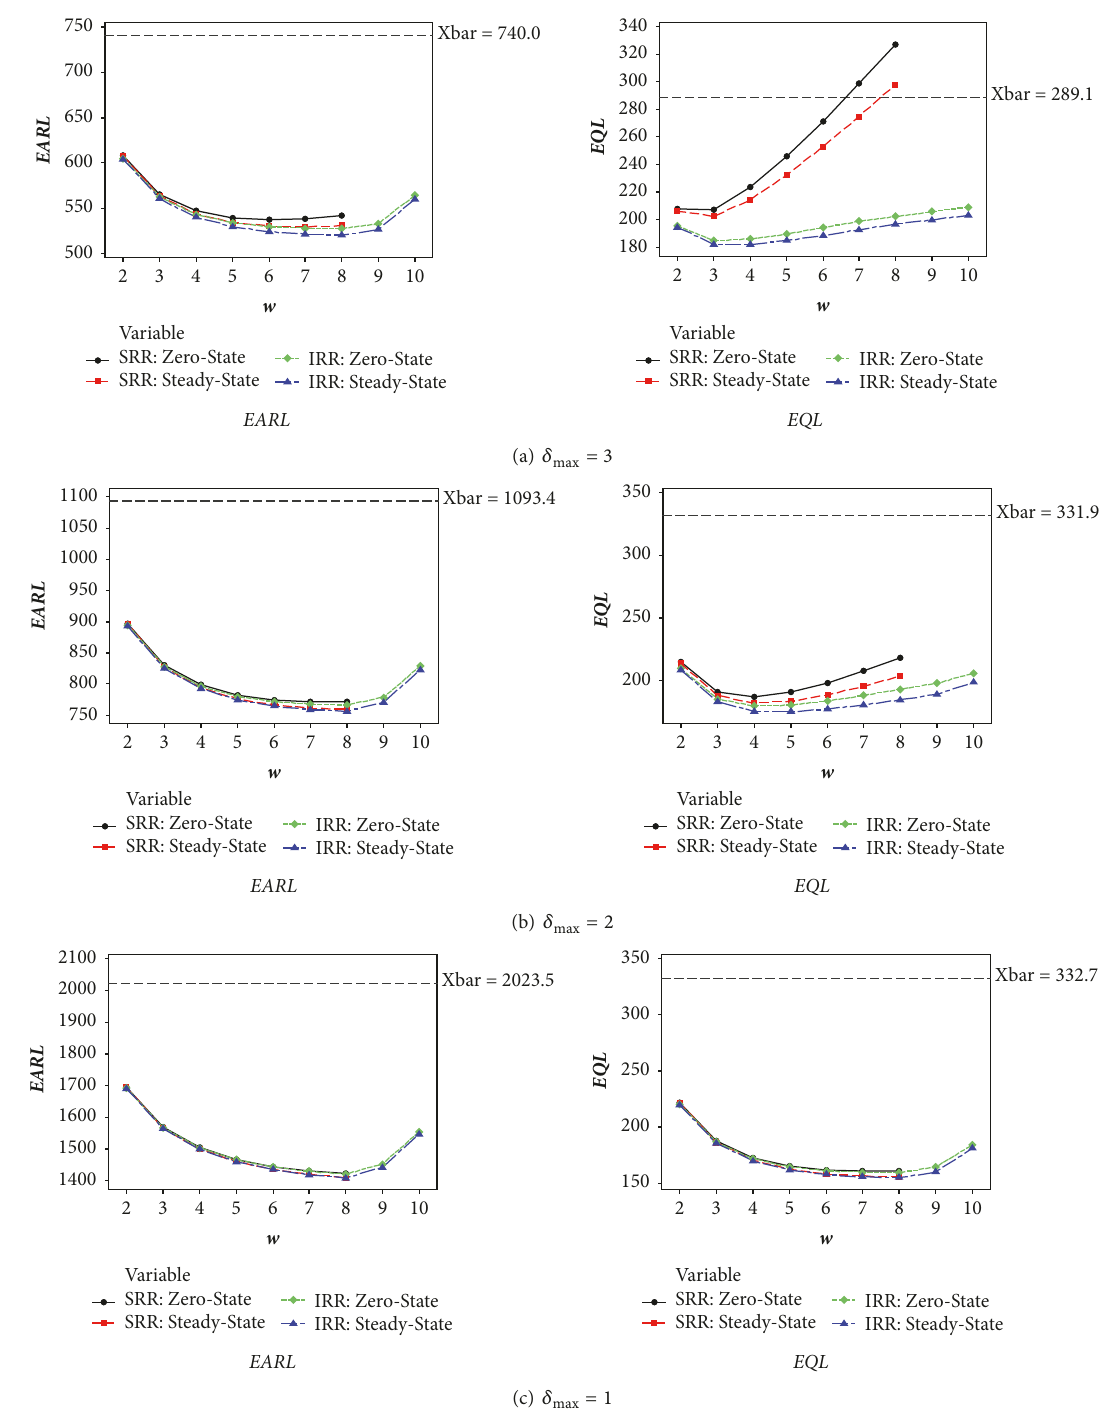
Figure 4: The zero-state and steady-state EARL and EQL values (with 𝛿 min = 0 ) of the two-sided side-sensitive SRR and IRR schemes when ARL 0 =